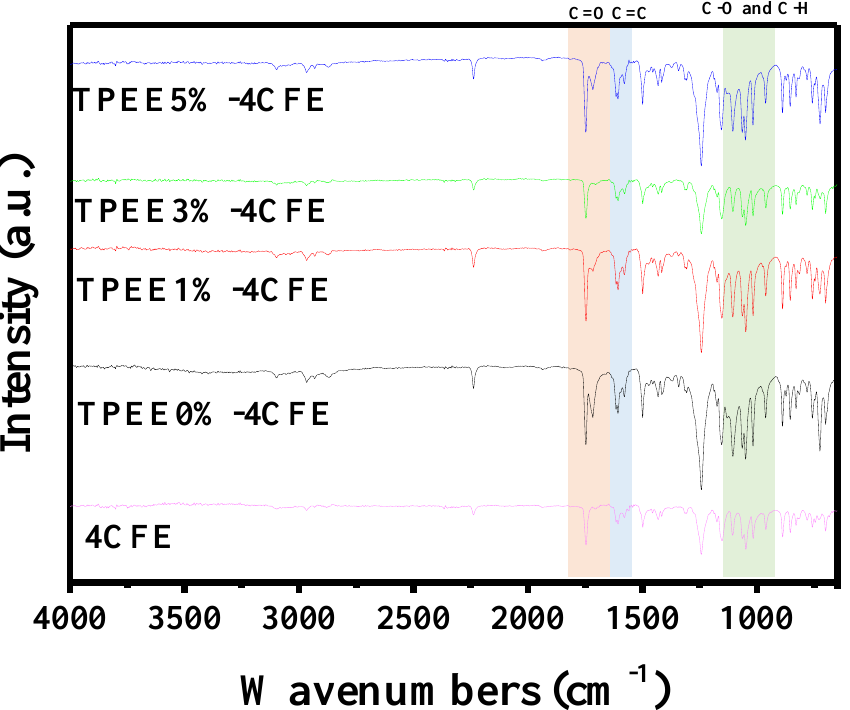
Figure 2. FT-IR of TPEEn%-4CFE and 4CFE.